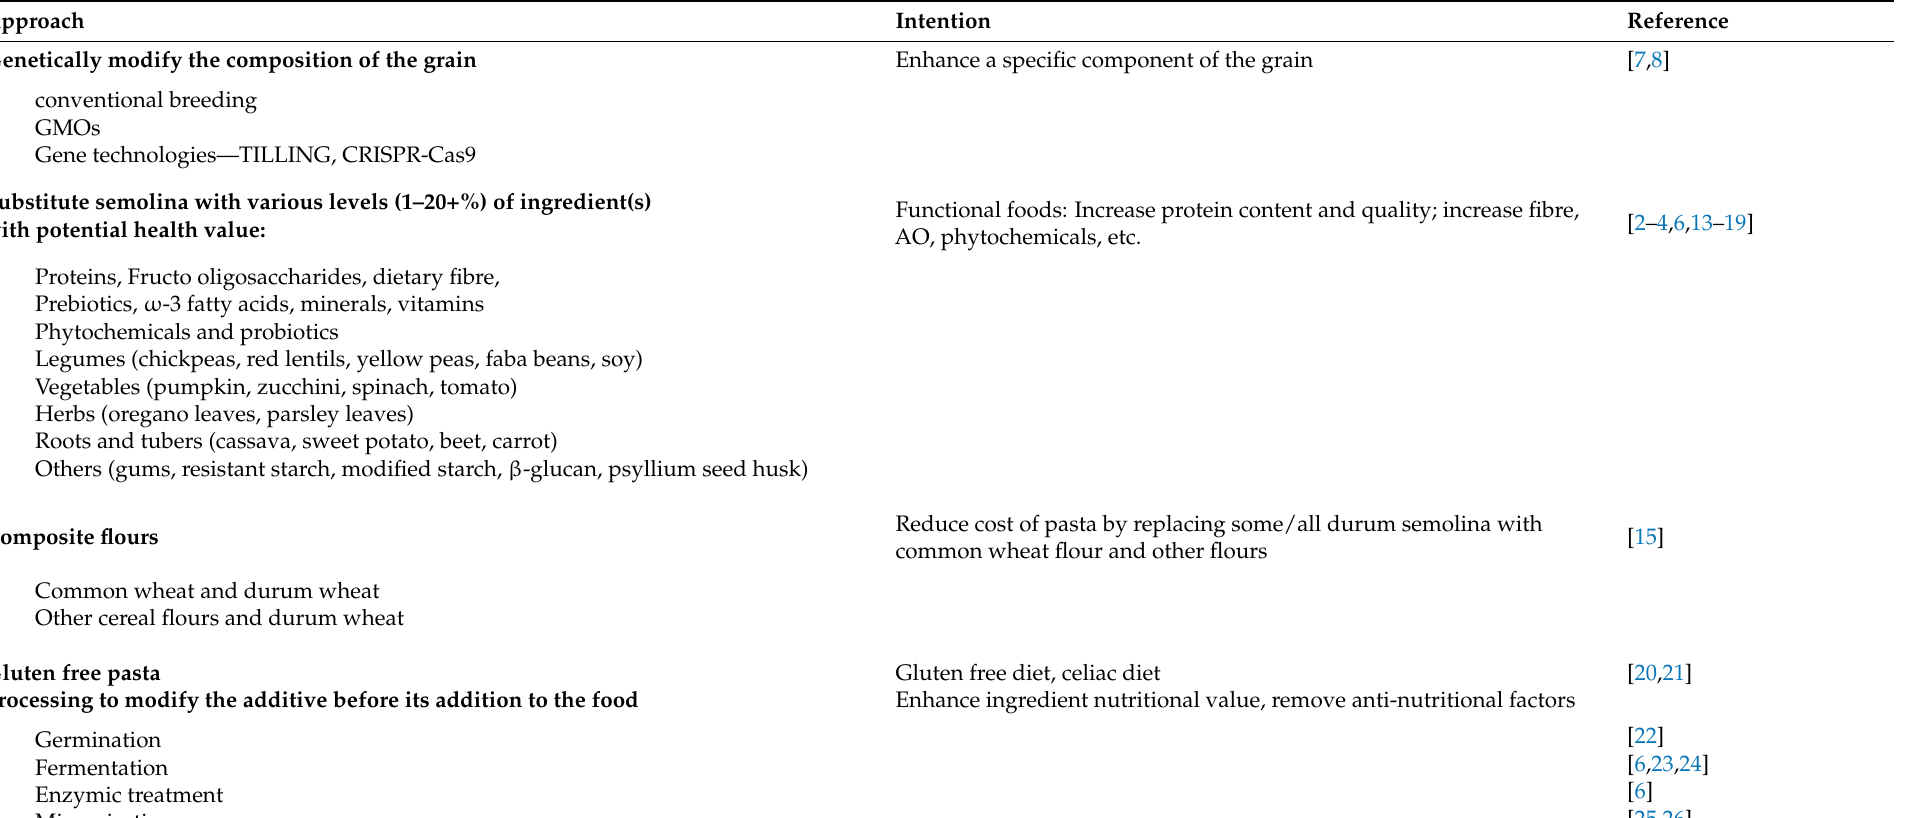
Table 1. Strategies to create pasta with added nutritional